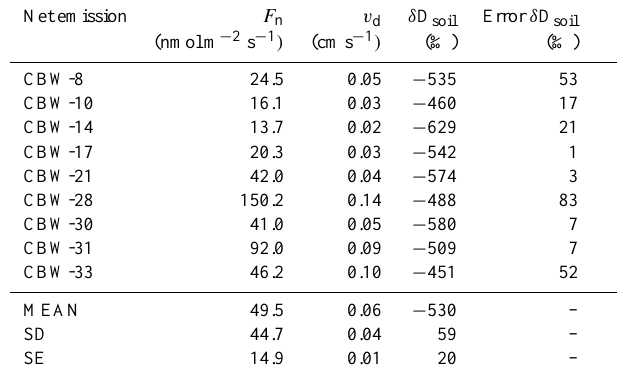
Table 2. Net flux, deposition velocity and δ D soil (including error) obtained from the mass balance model for the net H 2 emission ex-